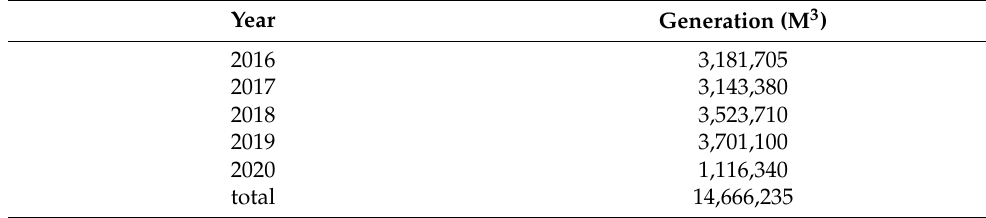
Table 2. Solid wastes generation during